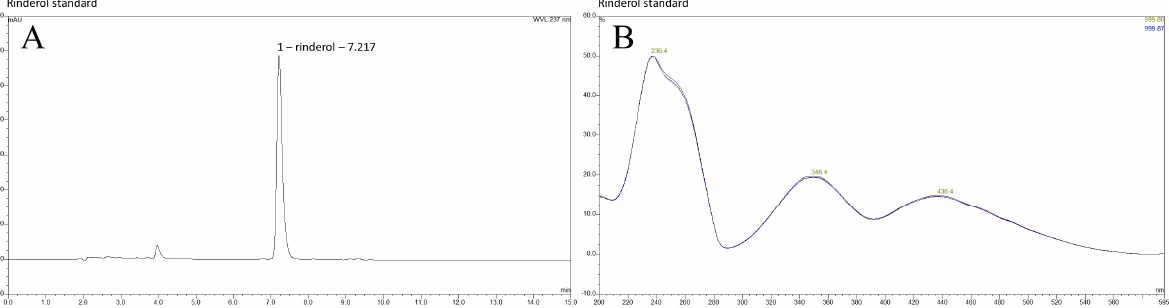
Figure 4. ( A ) Chromatogram of rinderol standard with the confirmed chemical structure used for compound identification in extracts obtained from investigated in vitro culture systems of R. graeca root lines; ( B ) UV ‐ Vis spectrum of rinderol standard, λ = 237